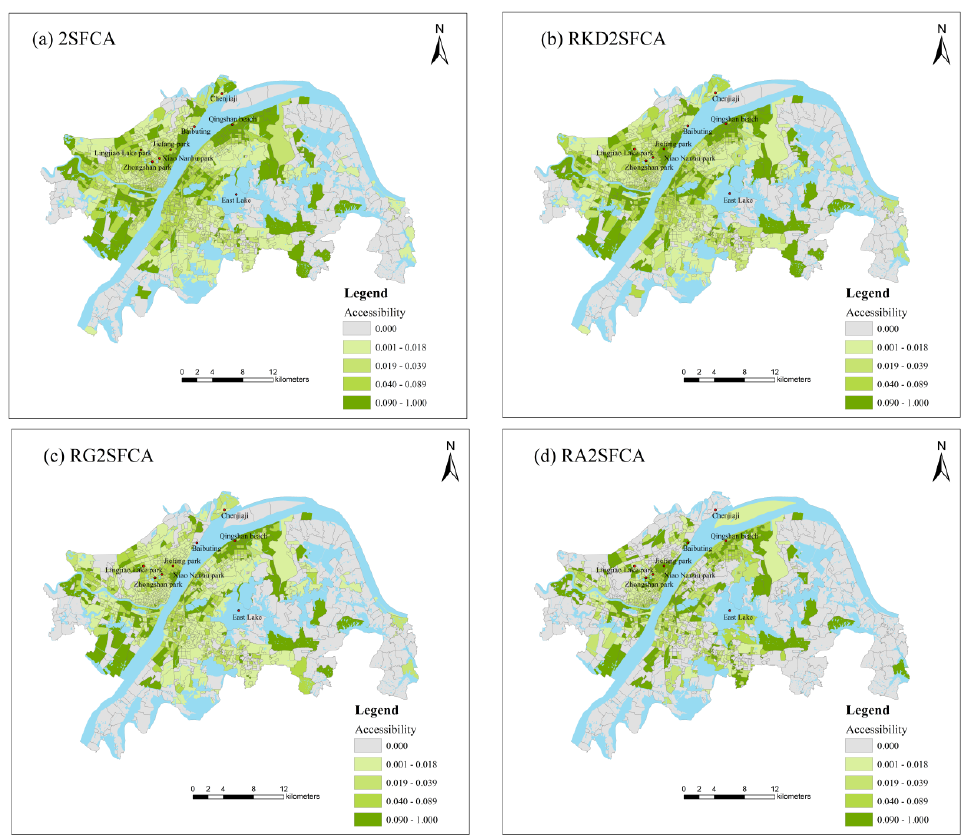
Figure 3. Accessibility of park green space in Wuhan under four methods: ( a ) the two–step floating catchment area method (2SFCA), ( b ) the road–based kernel density 2SFCA method (RKD2SFCA), ( c ) the road–based Gaussian 2SFCA method (RG2SFCA) and ( d ) the road–based gravity 2SFCA method